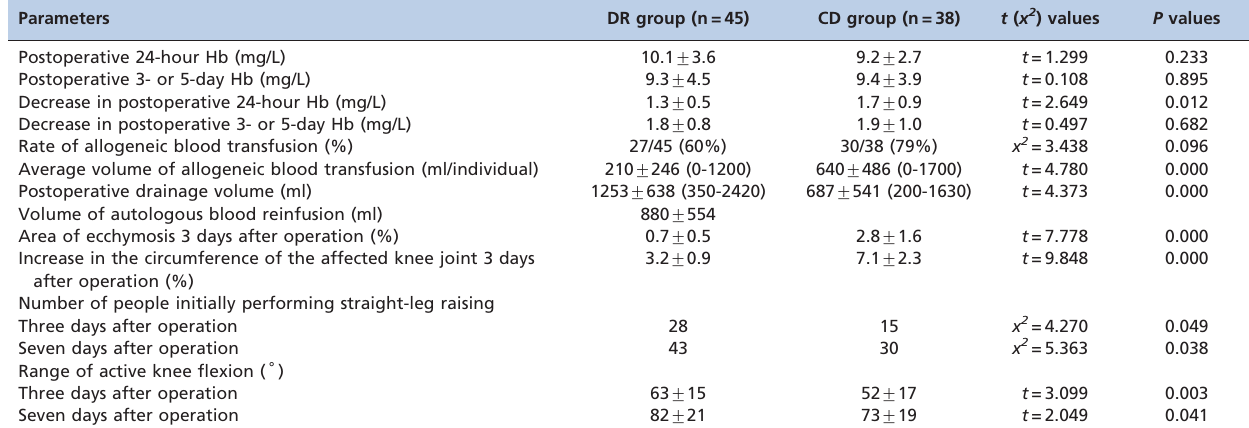
Table 2 - Postoperative Parameters in Both Groups (mean ¡ SD or number).